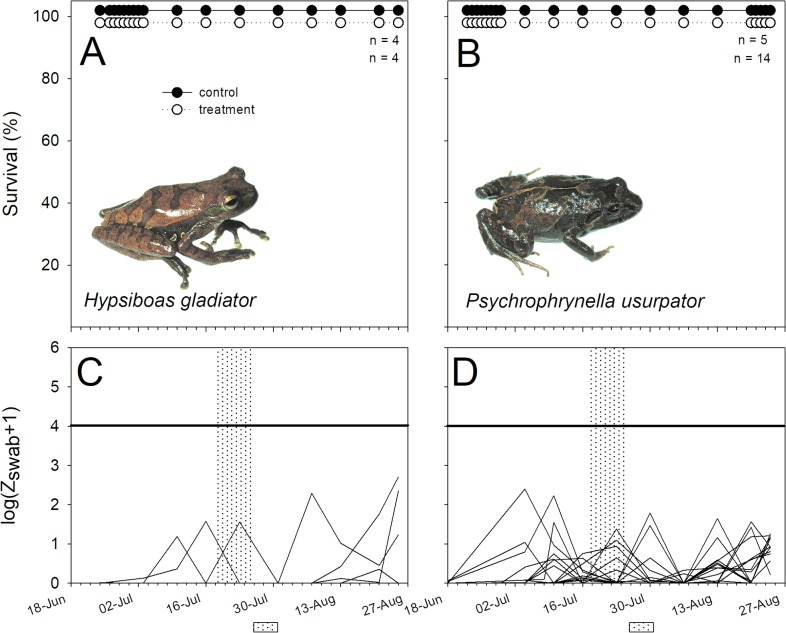
The gladiator frog Hypsiboas armatus (Hylidae) and the Cusco Andes frog Psychrophrynella usurpator (Craugastoridae) survived experimental infection.(A, B) Percentage survival, and (C, D) variation in log-transformed zoospore equivalents (Bd infection intensity) of Bd-exposed individuals of Hypsiboas gladiator (left panels) and Psychrophrynella usurpator (right panel). See Fig 2 for caption details.